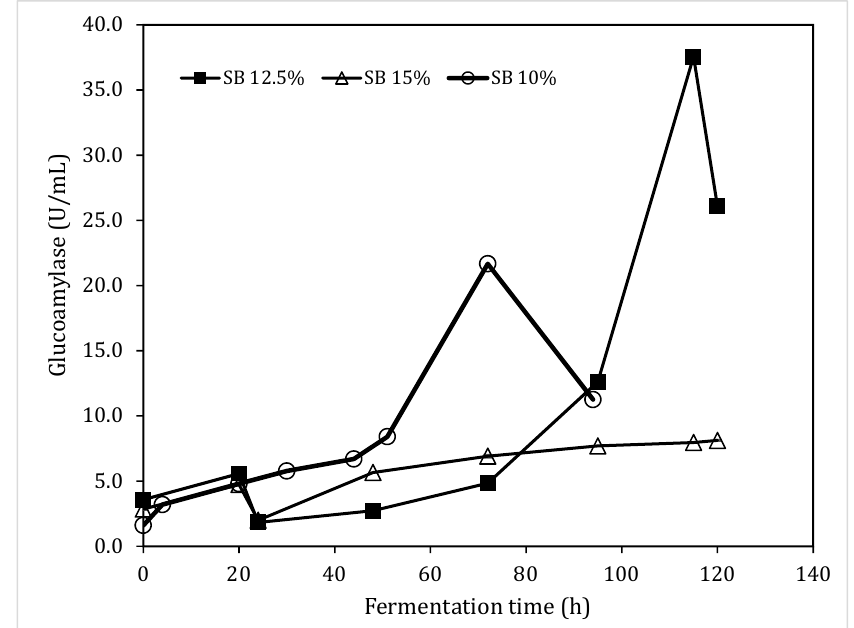
Figure 6. Typical glucoamylase accumulation profiles in 2-L fermenters using 10%, 12.5% and 15% (w/v) sorghum bran. Fermentation was carried out at 28 °C, 500 rpm, air aeration rate at 1.0 L/min, with mineral solution C at pH 6.0.